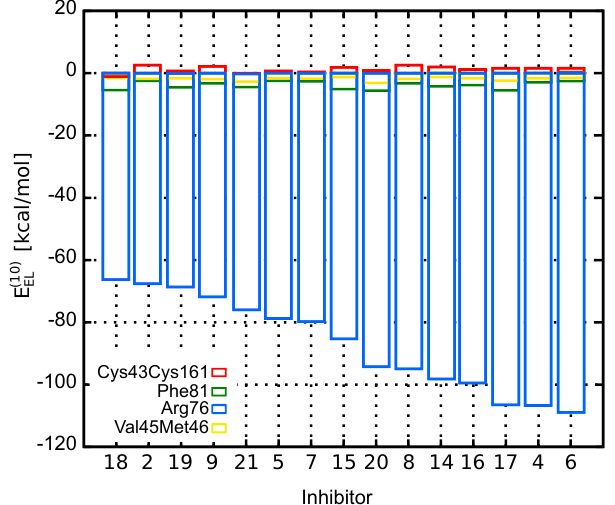
Figure 2. Contribution of EphA2 amino acid residues to the EphA2-inhibitor binding energy represented by the electrostatic term, E